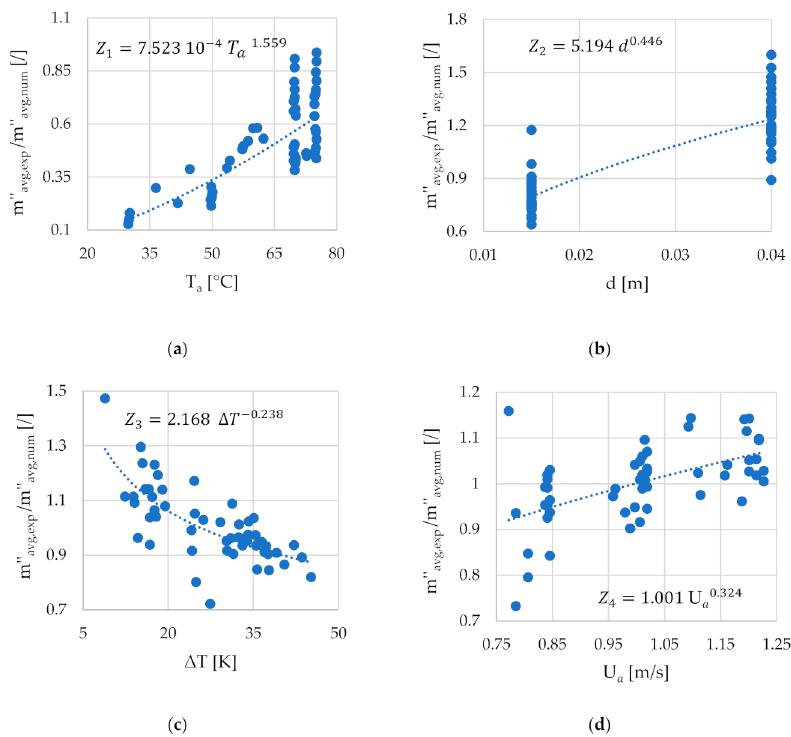
Figure 9. Functional dependence of the ratio of the experimental and calculated condensation mass flux and ( a ) temperature of humid air; ( b ) tube outer diameter; ( c ) temperature difference between humid air and wall; ( d ) humid-air